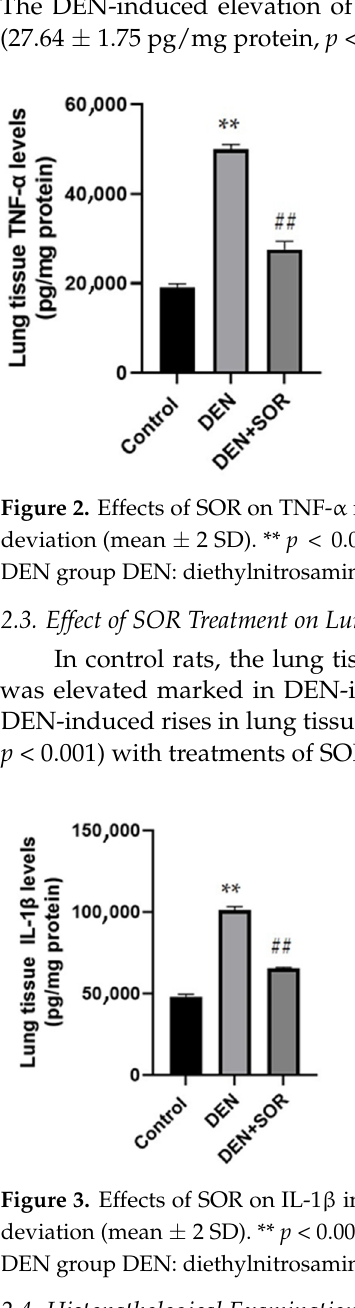
Figure 1. Effects of SOR on lung tissue ( A ) and serum ( B ) SOX-2 levels. ( n = 10) Data are expressed as the mean ± standard deviation (mean ± 2 SD) ** p < 0.001 compared with the control group, ## p < 0.001 compared with DEN group DEN: diethylnitrosamine; SOR: Sorafenib; SOX-2: Sex-determin- ing region Y (SRY)-box 2.